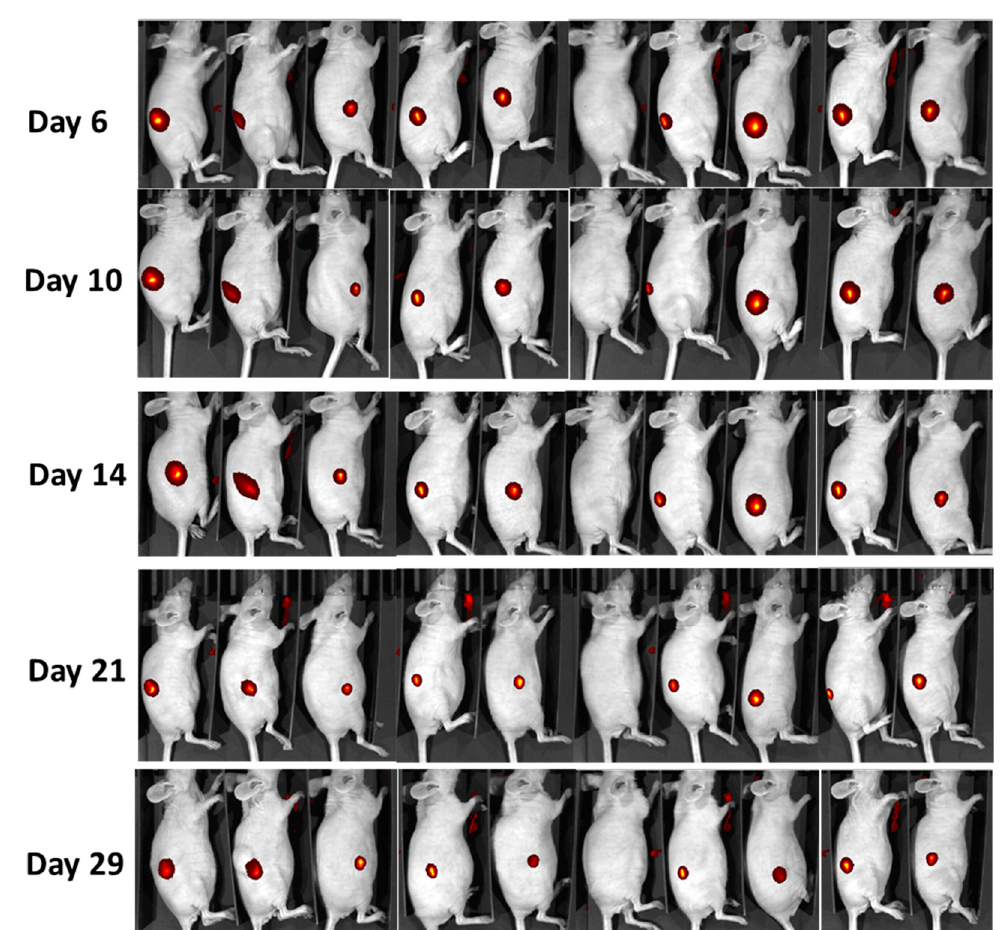
Figure 8. In vivo tumor monitoring by fluorescence macroscopy. For this, 2.5 × 10 6 RL Cy7-labeled cells were injected subcutaneously (sc) into the right flanks of Nude mice (n = 10). Tumor growth was followed by in vivo imaging fluorescence ( λ ex = 750 nm; λ em = 780 nm). Images show each individual mouse at different time points.